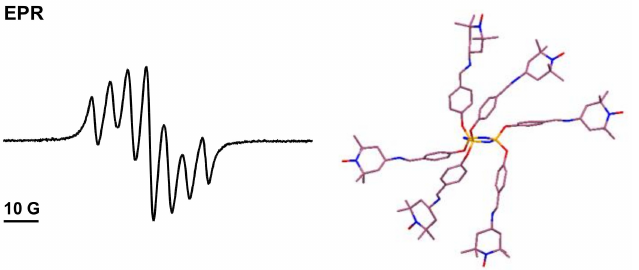
Figure 1. EPR spectrum at 350 K and the corresponding X-ray diffraction structure of cyclotriphosp- hazene functionalized with six TEMPO radicals. Published by Org. Lett . in 2013